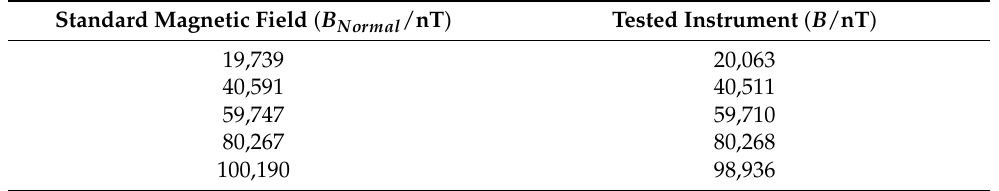
Table 2. The working range of the